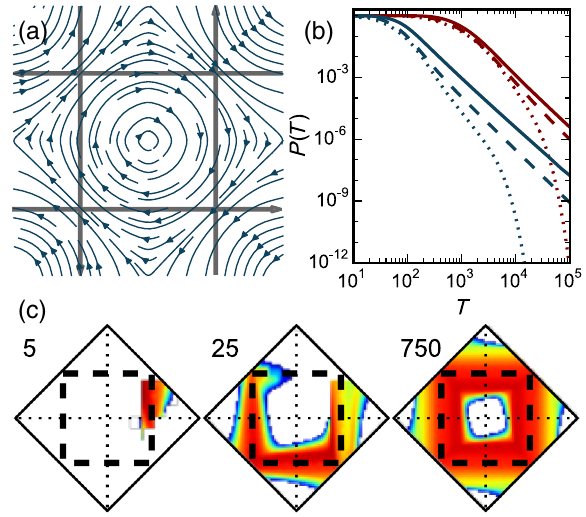
FIG. 5. Vortex model. (a) Streamlines (blue) for motion in the vicinity of an idealized square circuit of filaments (gray). (b) Survival probability in a vortex for M ¼ 1 (red) or M ¼ 5 (blue) in a vortex of size 40. The probability is initialized to a nonzero value at 3 = 4 of the diagonal and zero elsewhere. The binding radius is set to 1 = 5 , 1 = 7 . 5 , or 1 = 10 of the vortex length (dotted, dashed, or full lines). The probability has three phases: constant, power law, and exponential. The length of the power- law decay decreases with increasing binding radius. (c) Numerical solution of the master equation in a square vortex. In the example shown, the initial condition is a localized probability at a single location similar to (b). Here, the vortex size is 40, M ¼ 5 , the binding radius is 1 = 10 of the side length, and the motor step size is unit length. The colors correspond to the logarithm of the probability density of observing the motor at each location (red is highest) and is normalized in each subplot. The three panels show the master equation after 5, 25, and 750 iterations, respectively. The probability density spreads over time and the maximum rotates. The final image shows a pattern of localization that is stable as the integrated density continues to